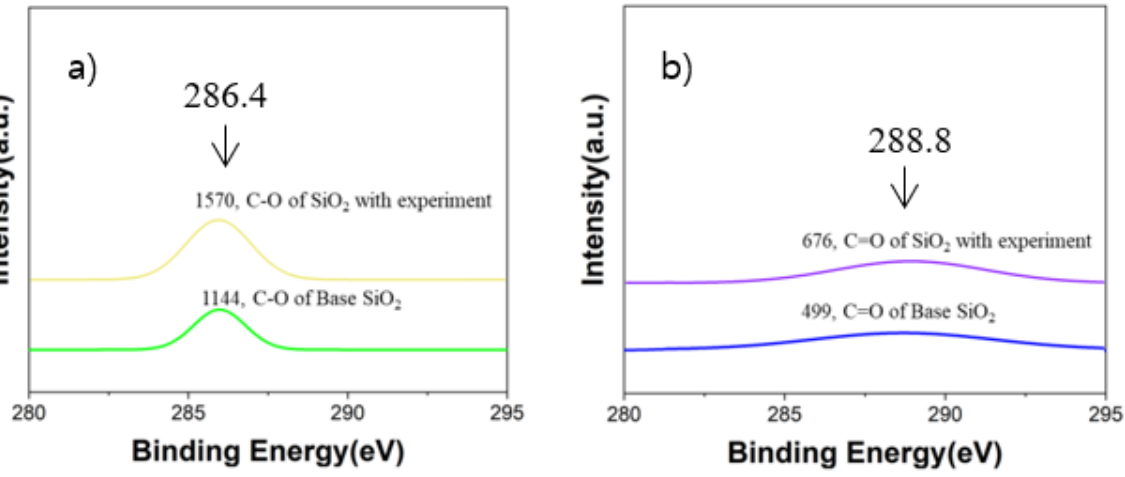
Figure 9. Binding energy peak of the C-O bonding on the base SiO 2 and after the vacuum carbon vaporization experiment ( a ); Binding energy peak of the C=O bonding on the base SiO 2 and after the vacuum carbon vaporization experiment ( b ).